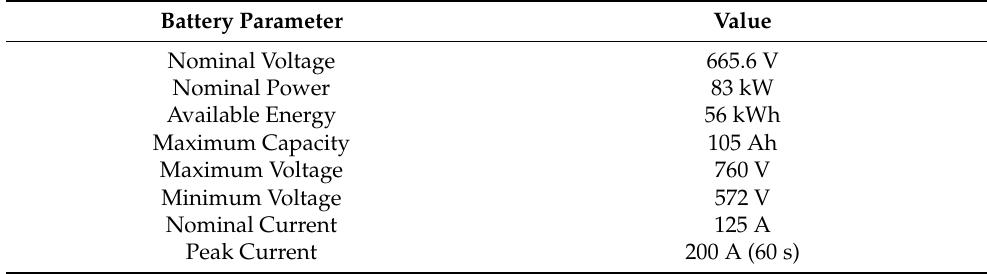
Table 4. Parameters of the selected lithium-ion